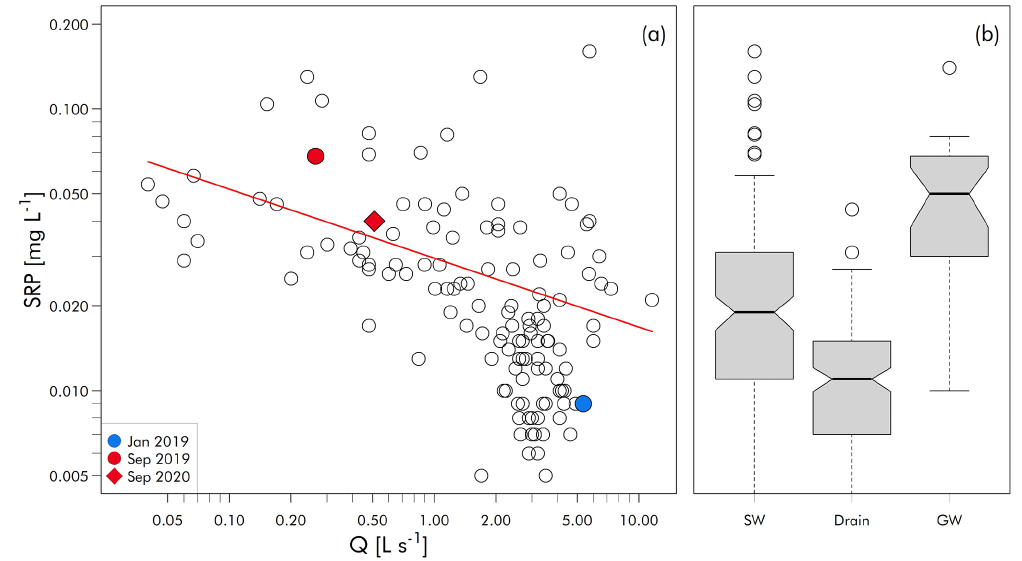
Figure 7. Long-term distribution of concentration–discharge relationships for stream SRP at the catchment outlet ( a ), box–whisker plots of concentrations in stream water (SW: n = 146), tile drains (drain: n = 138), and groundwater (GW: n = 25) ( b ). Data are from Kistner (2007) (drain); Dupas et al. (2017b) (SW); and UFZ TERENO monitoring, unpublished (GW) (see Supplement).